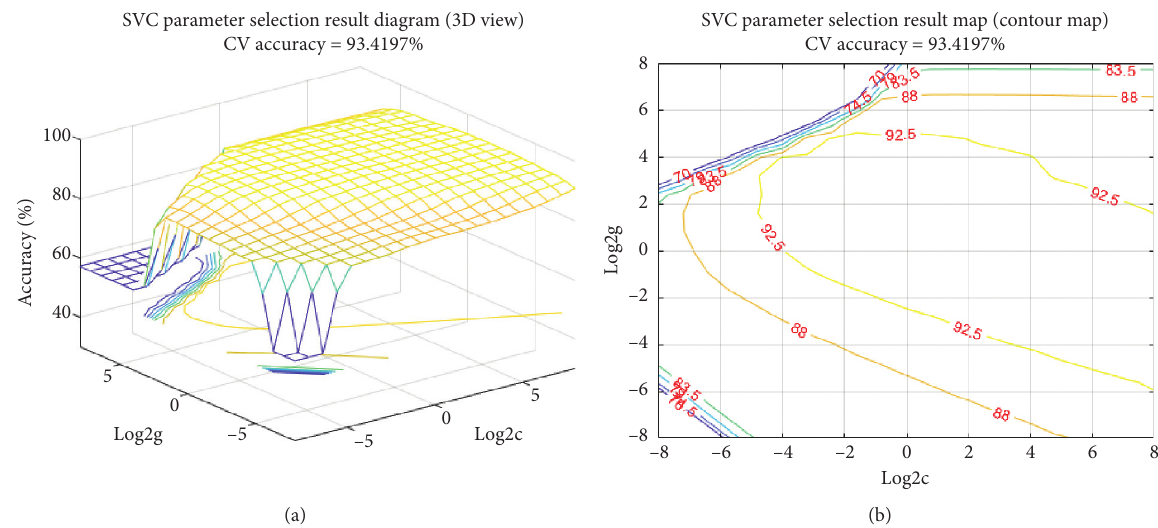
Figure 6: SVC parameter selection result graph. (a) 3D view. (b) Contour